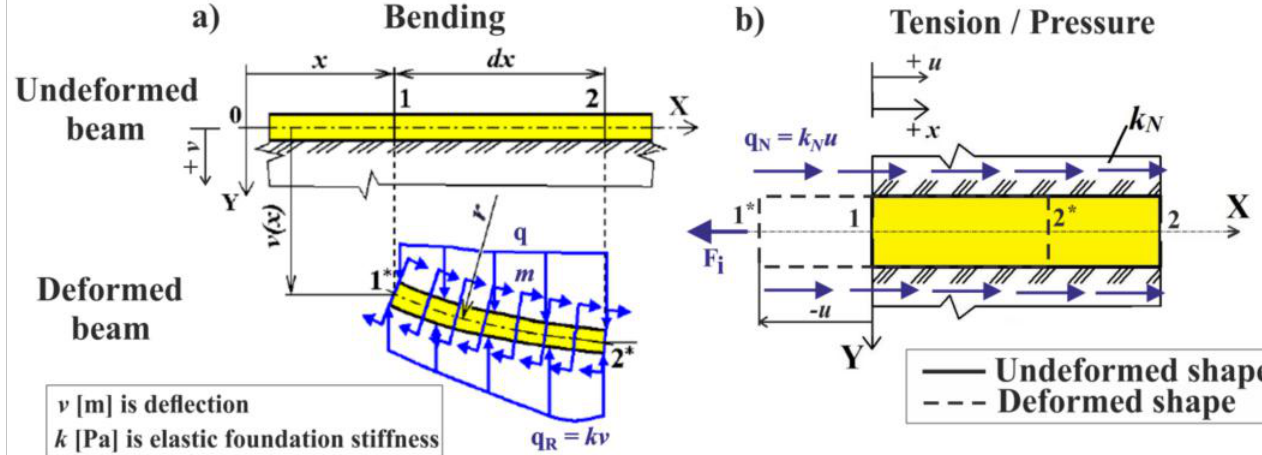
Figure 2. Elastic foundation due to the loads (points 1 and 2 are moved to new positions 1* and 2*). ( a ) Bending according to Winkler (distributed reaction force in foundation q R = kv in linear cases); ( b ) Tension/pressure—new tangential model according to Frydr ý šek and Michenkov á (distributed reaction force q N = k N u in linear cases, where k N [Pa] is elastic foundation stiffness, u [m] is axial displacement/elongation and F i [N] is a tensile/compression